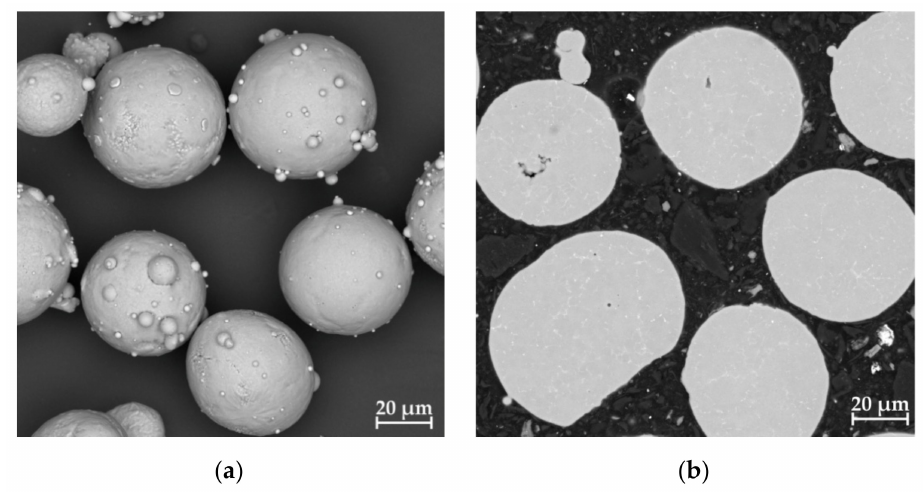
Figure 3. Particle morphology: surface ( a ) and cross-section cut ( b ). Table 2. Results of chemical analysis of AlSi10Mg powder. Element Content, (wt.%) Surface, Figure Spectrum Mark